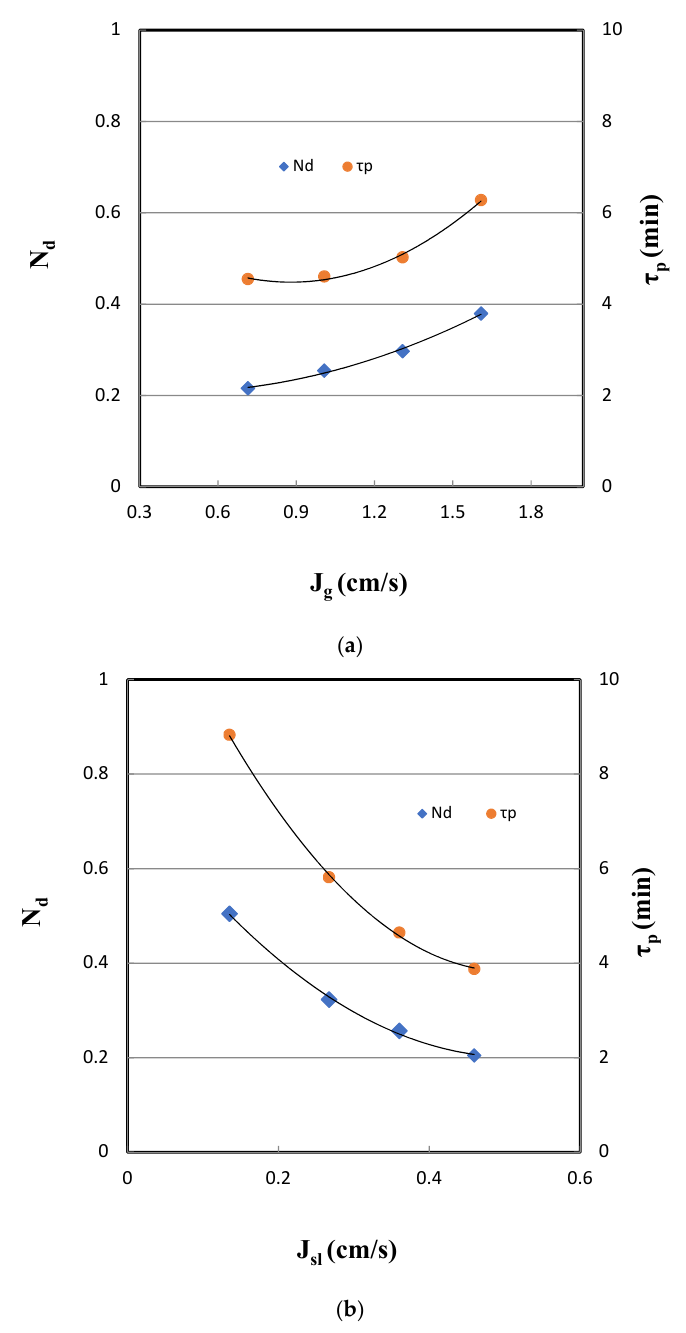
Figure 5. Effect of ( a ) superficial gas flowrate and ( b ) superficial slurry flowrate on vessel dispersion number.